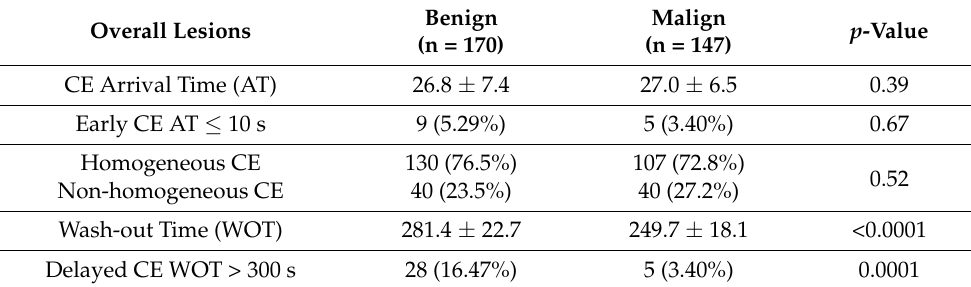
Table 3. Comparison of CEUS parameters between benign and malignant